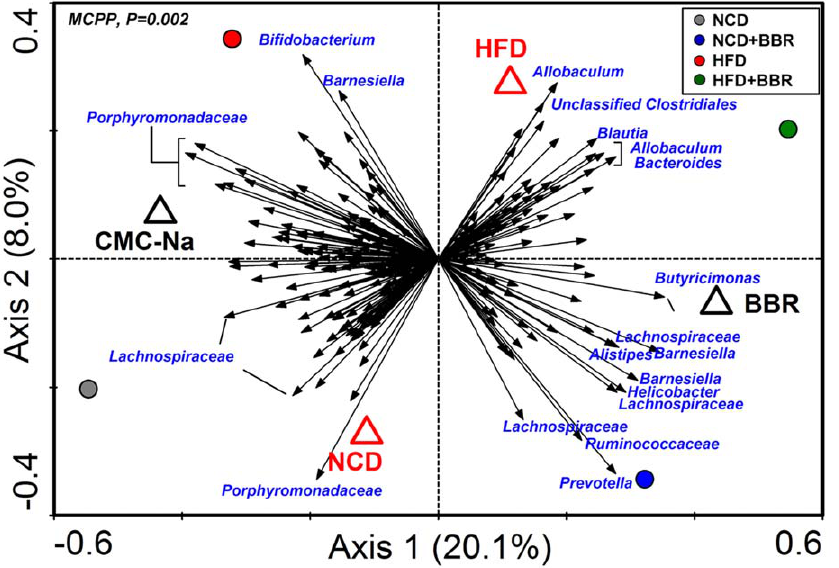
Figure 5. Distance triplot of the RDA of gut microbiota. Nominal environmental variables (BBR, CMC-Na, HFD, and NCD) are indicated by open triangles. Samples are indicated by filled circles. A total of 268 OTUs that had at least 20% of the variability in their values explained by the first axis are indicated by black arrows. Relative better-fitting species are labeled with taxonomic names (genus or family names). Upper left, P-value obtained by MCPP. BBR, berberine; CMC-Na, sodium carboxymethylcellulose as a vehicle control; HFD, high-fat diet; NCD, normal chow diet.